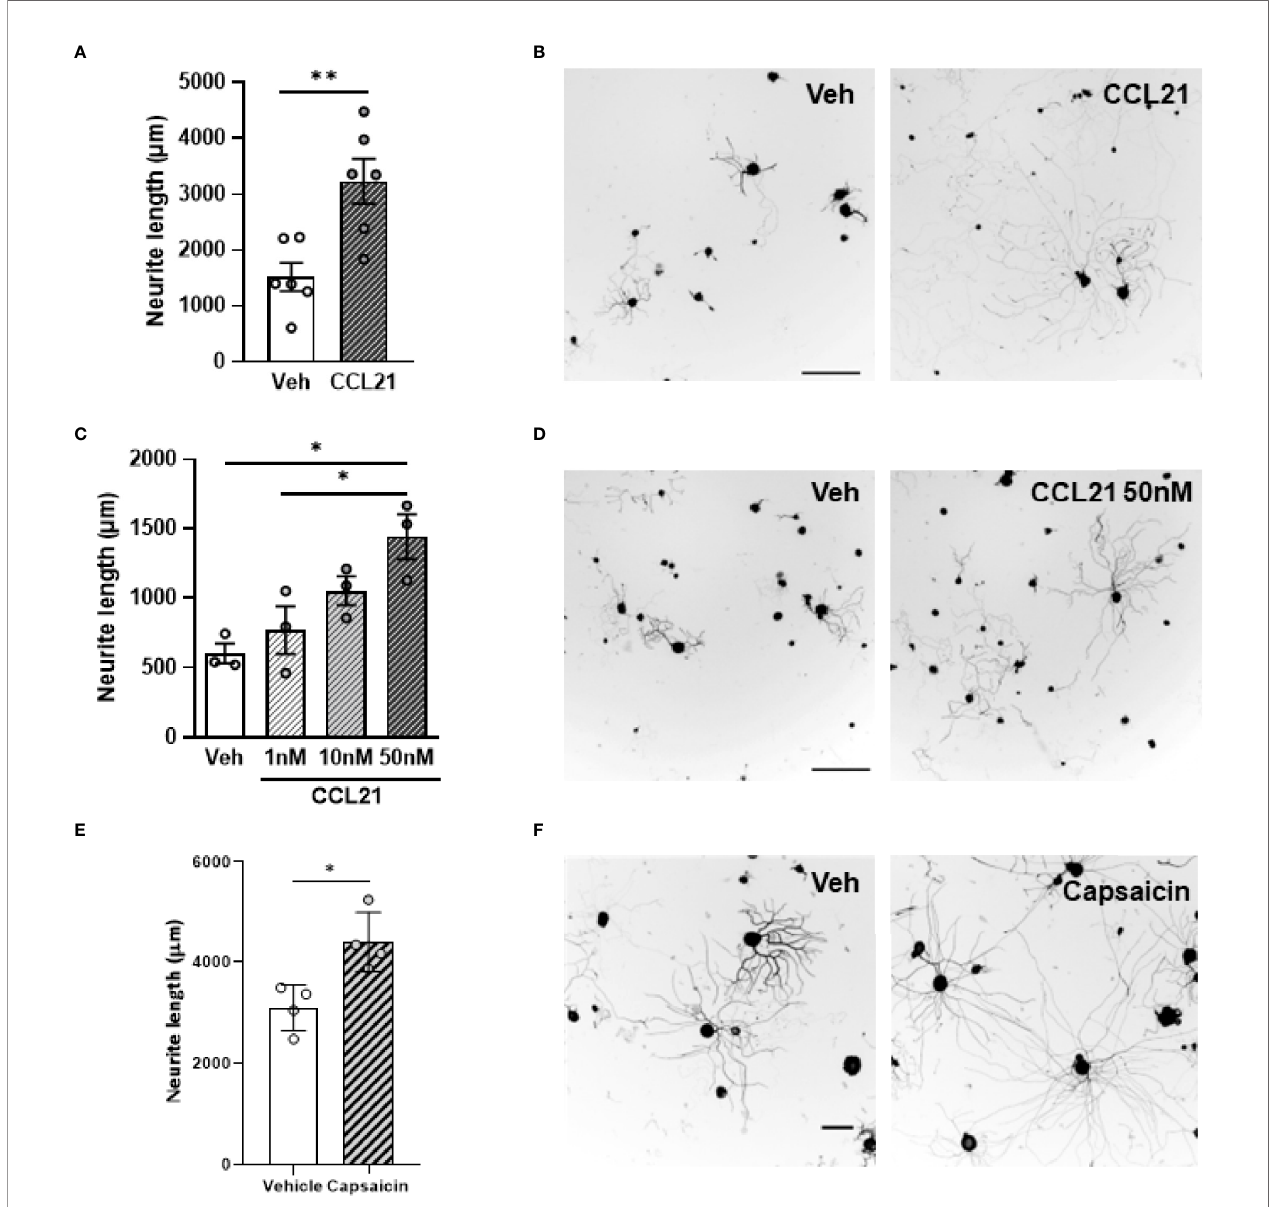
FIGURE 2 | CCL21 enhances DRG neurite outgrowth. (A) Ex vivo CCL21 administration in the sciatic nerve promoted neurite outgrowth of DRG large-diameter neurons. Data are expressed as average neurite length per neuron ± s.e.m; Student ’ s t-test; ** p < 0.01; n=6 sciatic nerves. (C) Dose-dependent increase in neurite length of in vitro CCL21-treated DRG large-diameter neurons. Data are expressed as average neurite length per neuron ± s.e.m; One-way ANOVA, Bonferroni ’ s post-hoc ; * p < 0.05; n=3 wells. (B, D) Tuj-1 representative immunostainings (B : ex vivo D : in vitro ) after 24h in culture. Scale bar: 250 m m. (E) Intraplantar capsaicin administration increased neurite outgrowth of ex vivo cultured DRG large-diameter neurons. Data are expressed as average neurite length per neuron ± s.e.m; Student ’ s t-test; * p < 0.05; n=4 biological replicates. (F) Tuj-1 representative immunostainings after 24h in culture. Scale bar: 100 m